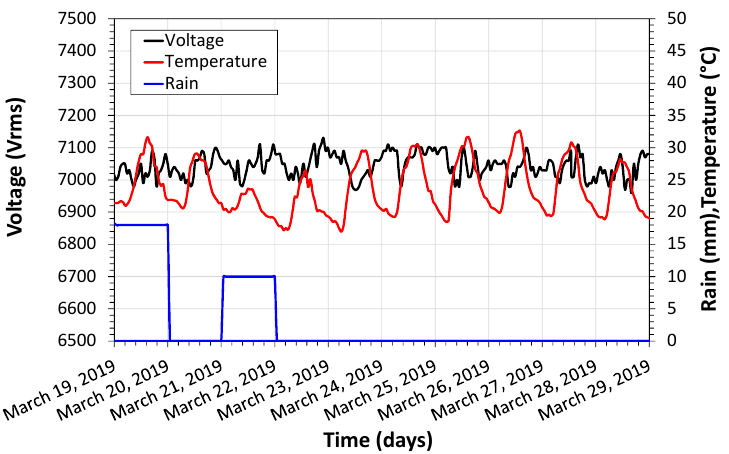
Figure 13. Voltage, temperature variation, and precipitation measurements during the field-test of the sensor in a standard application.